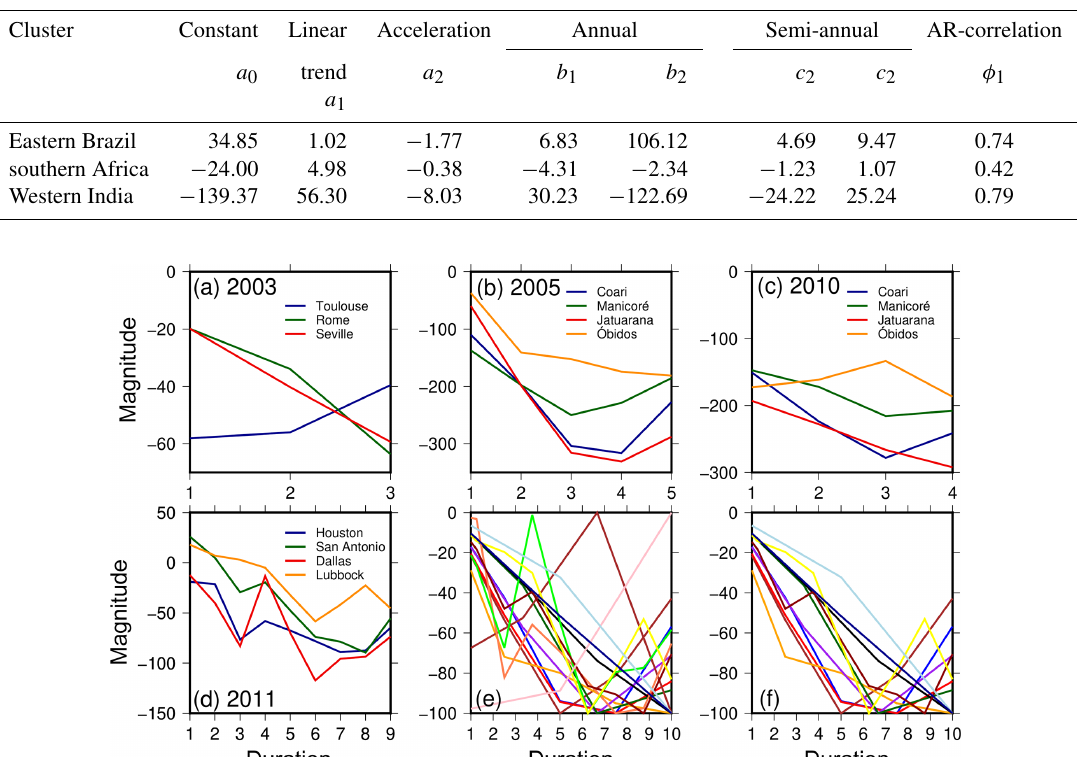
Table 3. Coefficients ( a 0 to c 2 from Eq. 18 and φ 1 from Eq. A1) for signals contained in GRACE-TWSC that were extracted within the clusters of eastern Brazil, southern Africa, and western India. These coefficients are used to simulate synthetic TWSC.